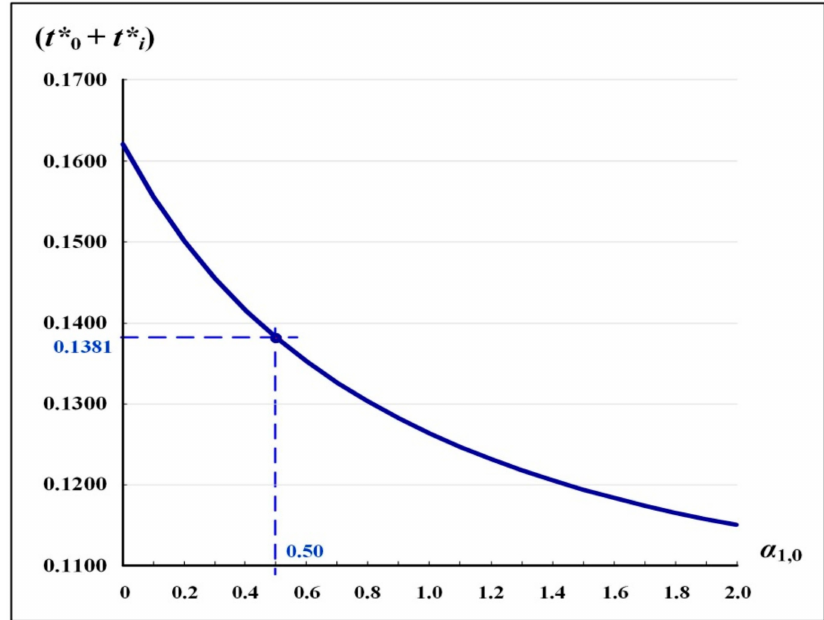
Figure 5. The impact of the adjustable-rate on ( t 0 * + t i *).